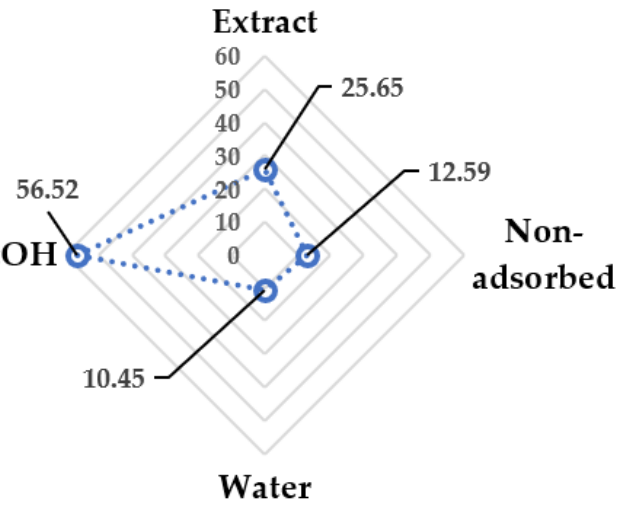
Figure 13. Purification trend of resin process. Reported values are expressed as percentages (mg GAE on 100 mg EXTR ). on 100 mg EXTR ).